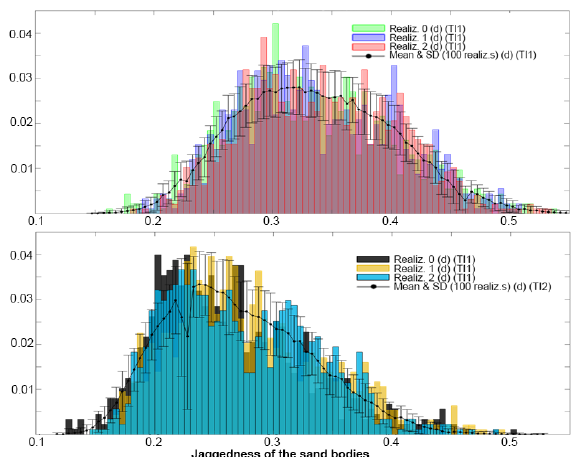
Figure A3. Probability of the jaggedness of the sand bodies (with a size larger than 1000) for the realizations obtained by using the conditioning strategy in Table 1 and respectively (a) TI1 and (b) TI2 (Fig. 10). While the histograms correspond to the first three realiza- tions, the dots and error bars represent the mean and the standard deviation calculated by using 100